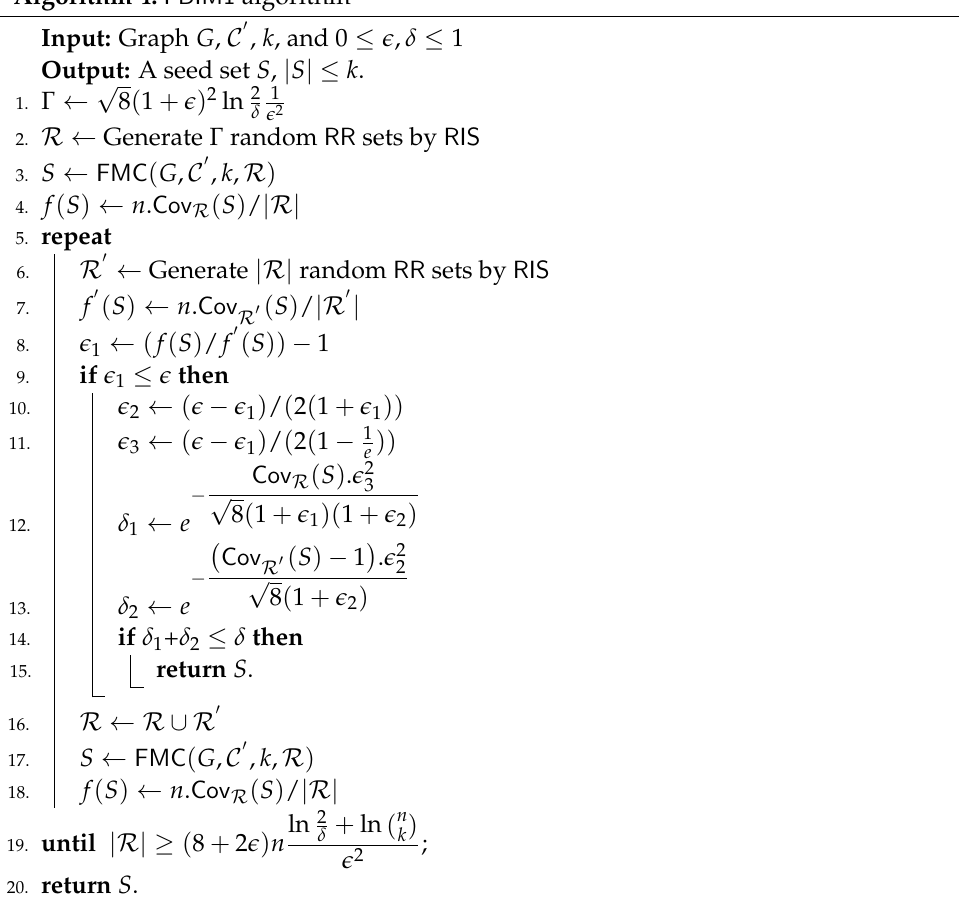
Algorithm 4: FBIM1